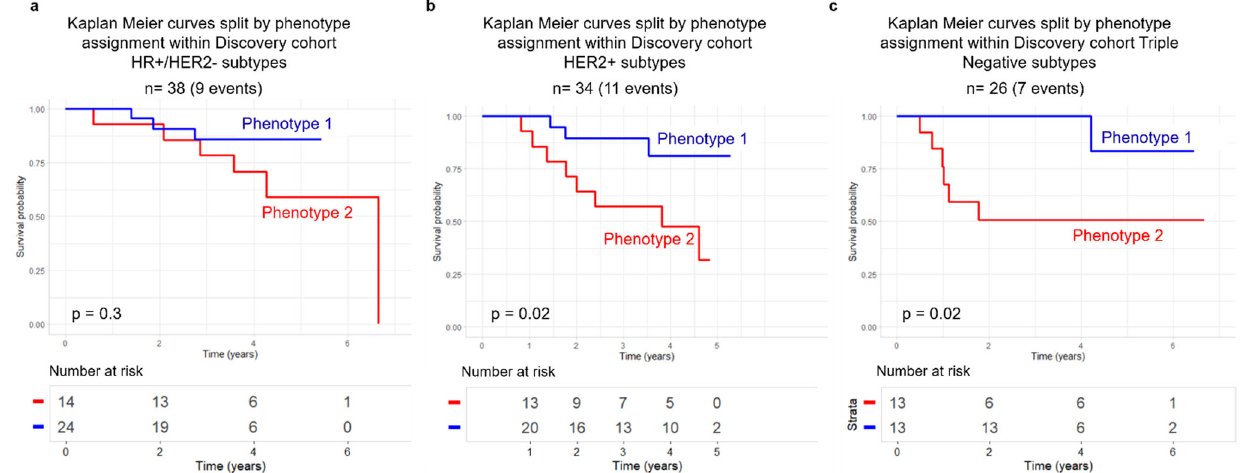
Fig. 2 Survival Analysis for Molecular Subtypes of Breast Cancer. Kaplan Meier recurrence free survival (RFS) curves split by phenotype assignment for ( a ) HR + /HER2- ( n = 38), ( b ) HER2 + (n = 34) and ( c ) Triple Negative ( n = 26) molecular subtypes of breast cancer in the discovery cohort.